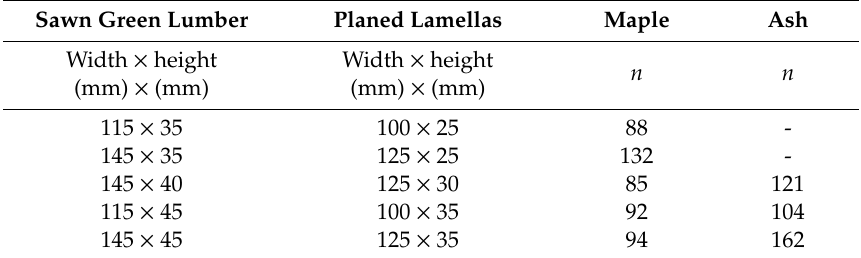
Table 1. Nominal dimensions and quantities ( n ) of sawn green lumber and the resulting planed lamellas (dry-dressed lumber).